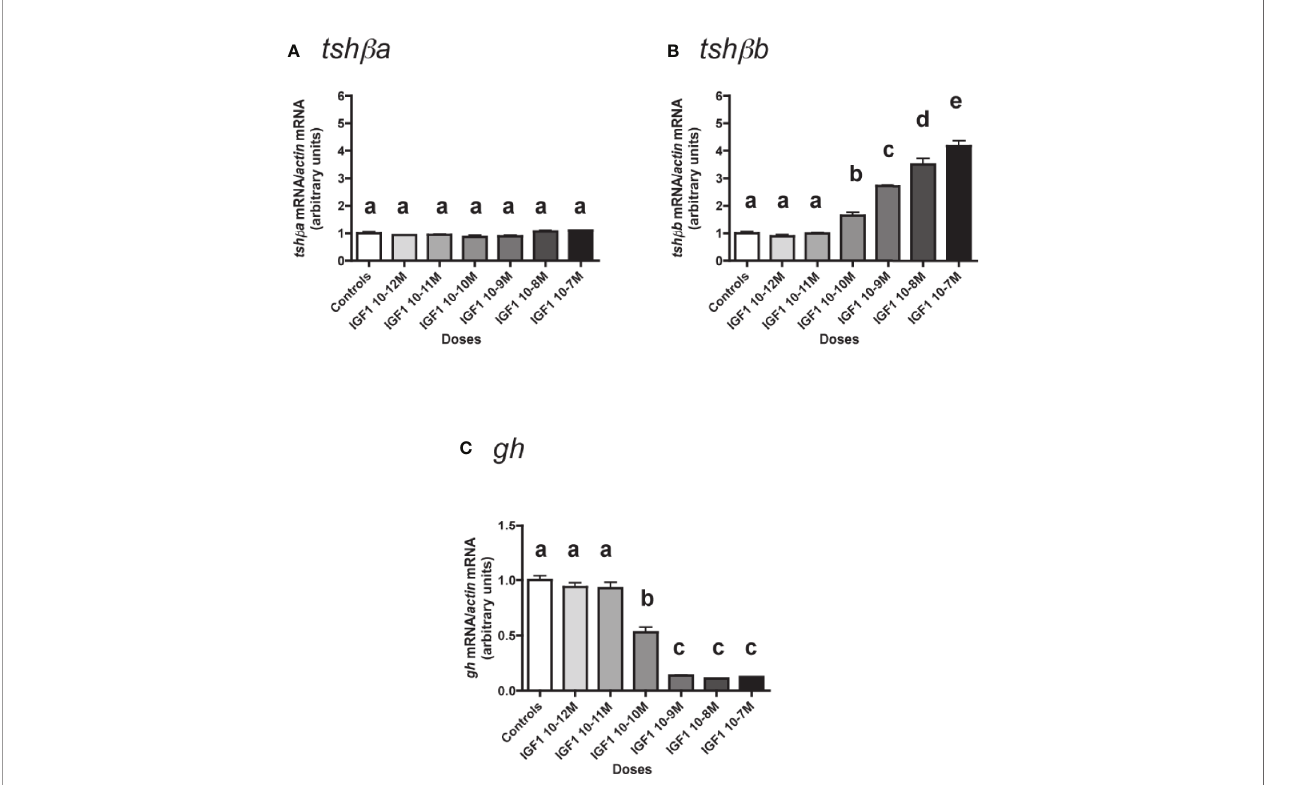
FIGURE 7 | Effects of IGF1 on tsh b a , tsh b b and gh transcript levels in primary cultures of Atlantic salmon pituitary cells. Pituitary cells from juvenile Atlantic salmons were treated with various concentrations of IGF1 for 10 days. The mRNA levels of tsh b a (A) , tsh b b (B) , and gh (C) were quanti fi ed by qPCR. Data were normalized against b -actin . The Figure displays the results from a representative experiment of three independent cell culture experiments. Mean ± SEM; n = 5 well replicates. Different letters indicate signi fi cant differences,